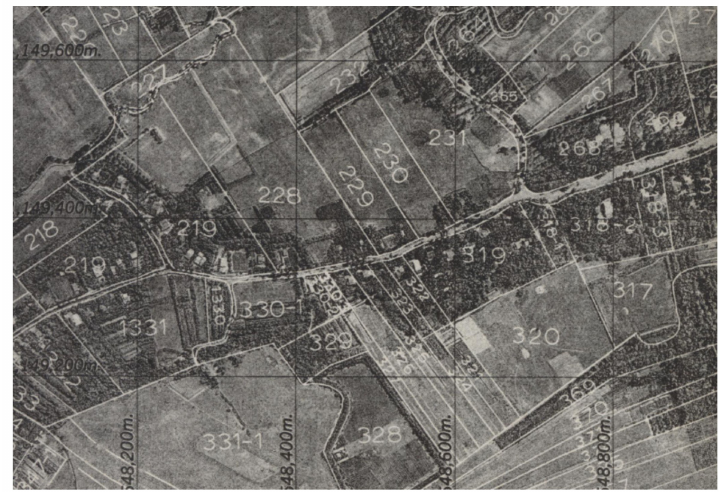
Figure 7. Conflict-strewn Vietnam demonstrated the potential for photogrammetric methods for fast-tracked in parcel mapping to support land reform (Adapted from